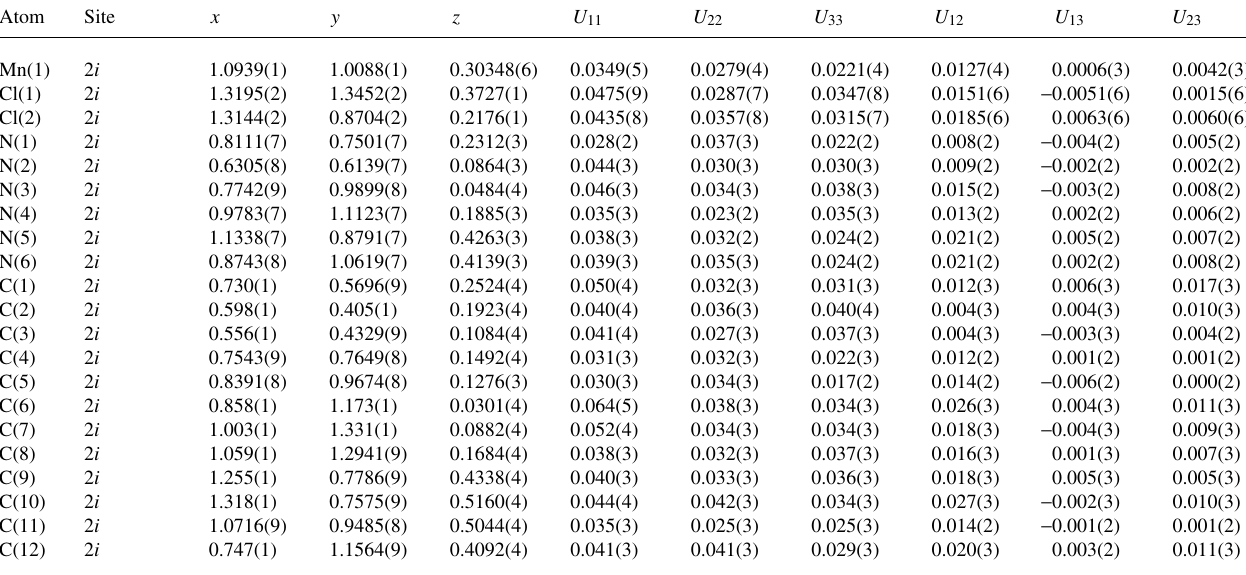
Table 3. Atomic coordinates and displacement parameters (in Å 2 )